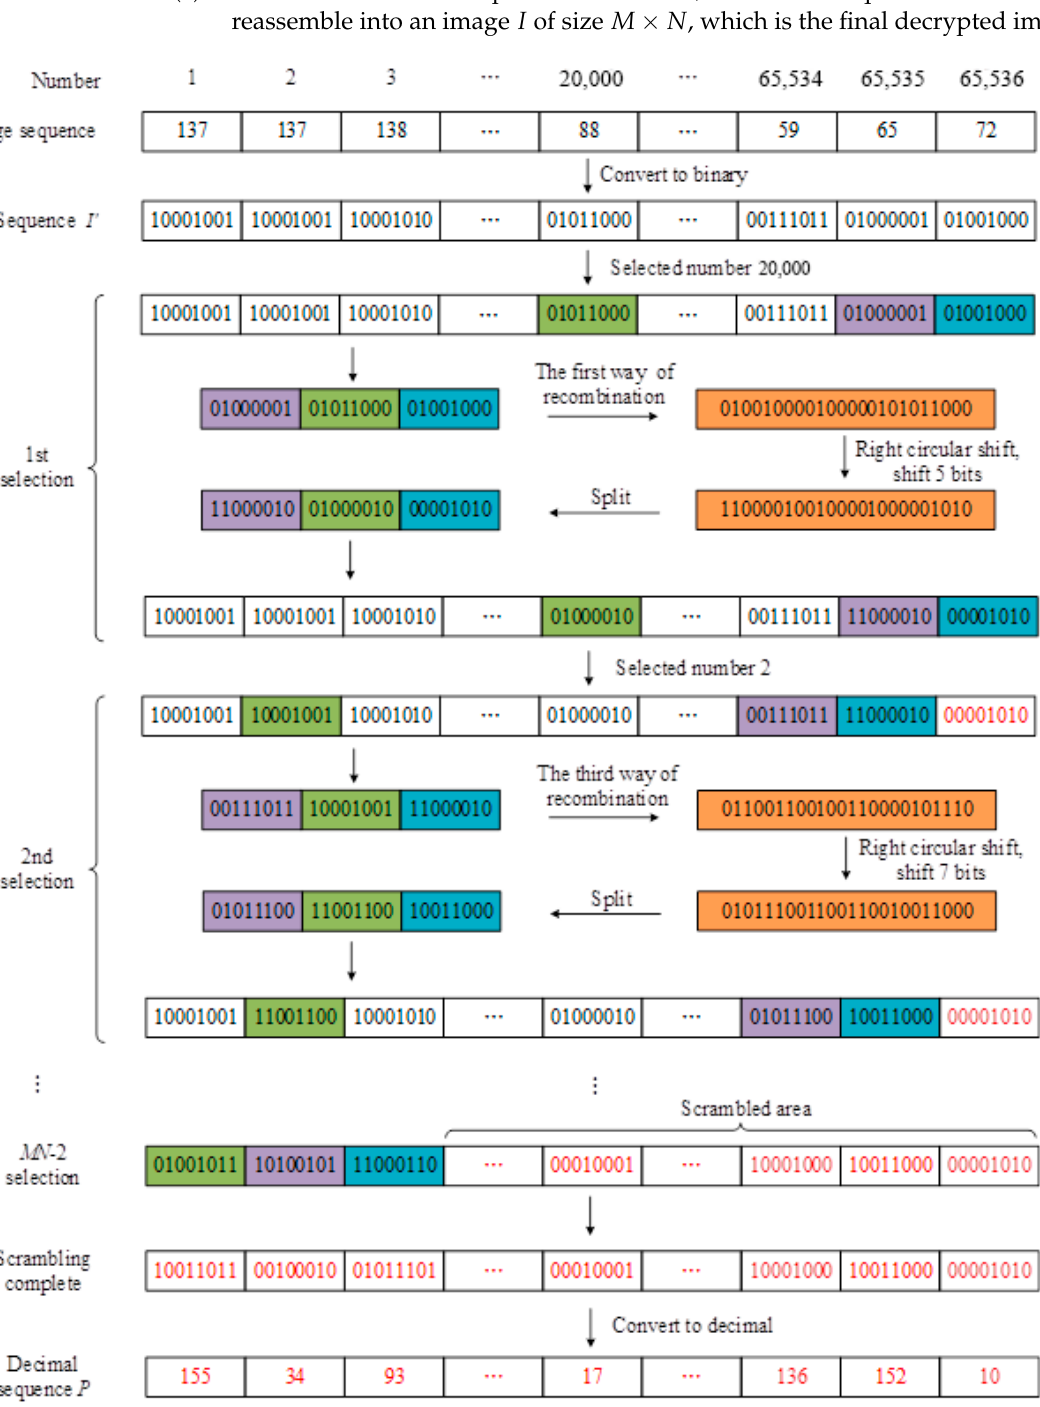
Figure 6. Schematic diagram of the stage-merging bit-scrambling process.